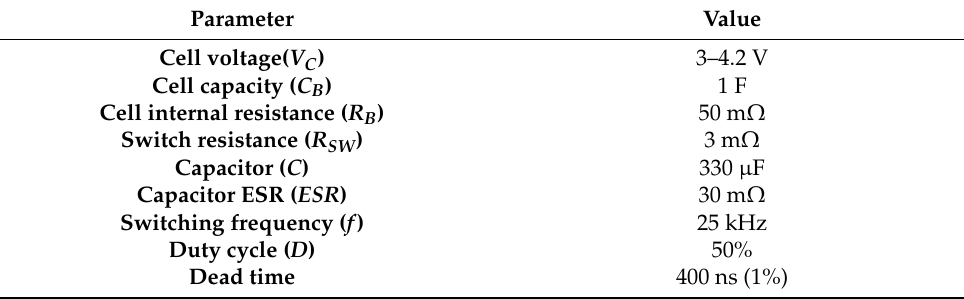
Table 2. Simulation parameters.